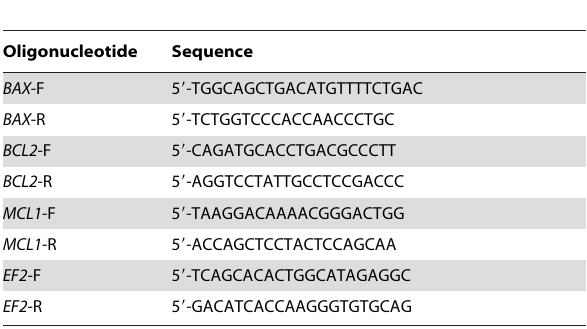
Table 1. Oligonucleotides used in this